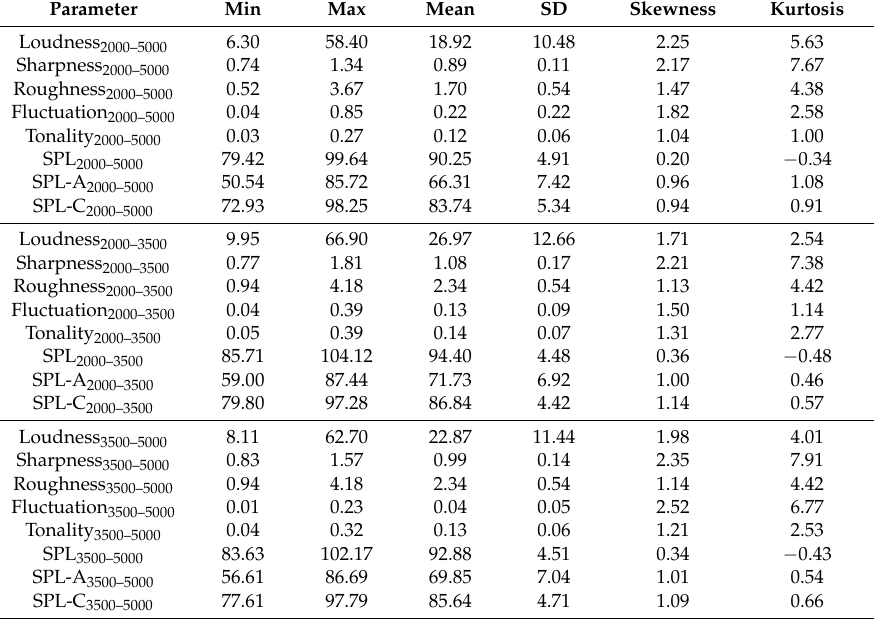
Table 1. Result of descriptive statistics for psychoacoustic parameters and acoustic